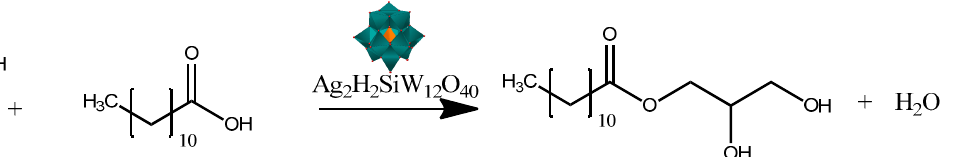
Figure 15. Esterification of glycerol with carboxylic acids (i.e., C2–C4) with a AgH 2 PW 12 O 40 catalyst (adapted from ref. [54]). Reaction conditions: temperature (393 K); alcohol/acid molar ratio (1:10); catalyst loading (1 wt.%); reaction time (15 min).